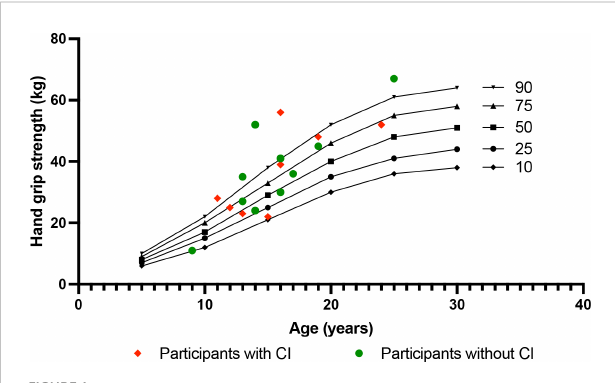
FIGURE 1 Hand grip strength. Results of hand grip strength measurement in participants with KS (red squares and green circles) and age- appropriate percentiles according to Dodds et al. (21) Presence of chronotropic insuf fi ciency (CI) in participants is indicated by color (red squares = with CI; green circles = without CI).